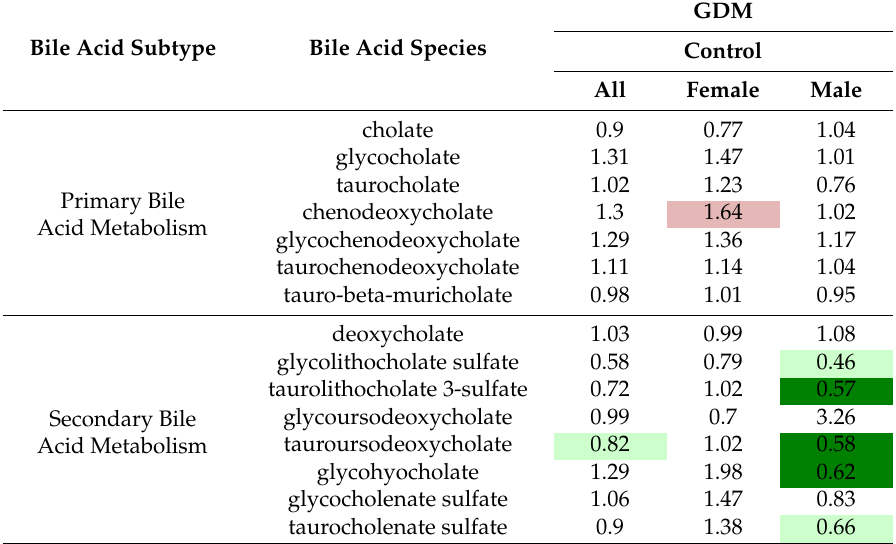
Table 7. Changes in bile acid metabolism in second trimester AF of women with